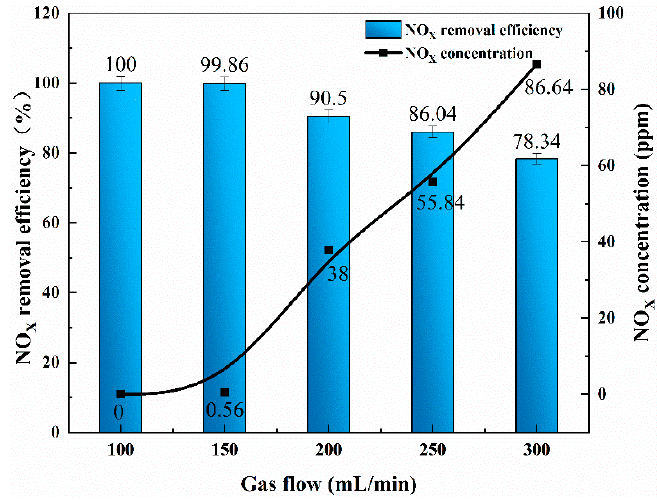
Figure 7. Effect of gas flow rate at inlet end on NO x removal efficiency.